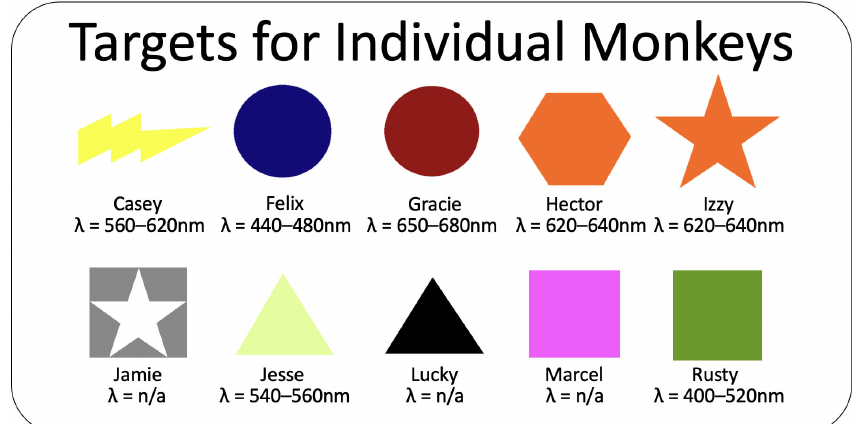
Figure 4. Images of the physical targets assigned to each monkey in the colony, together with the wavelengths of the light they reflected in the visible spectrum. The targets for Jamie, Lucky, and Marcel do not reflect light from a single well-defined band. Targets were originally made out of laminated construction paper and were replicated as precisely as possible when moved to the computer touch screen use. Note the overlap of shape and color for several of the